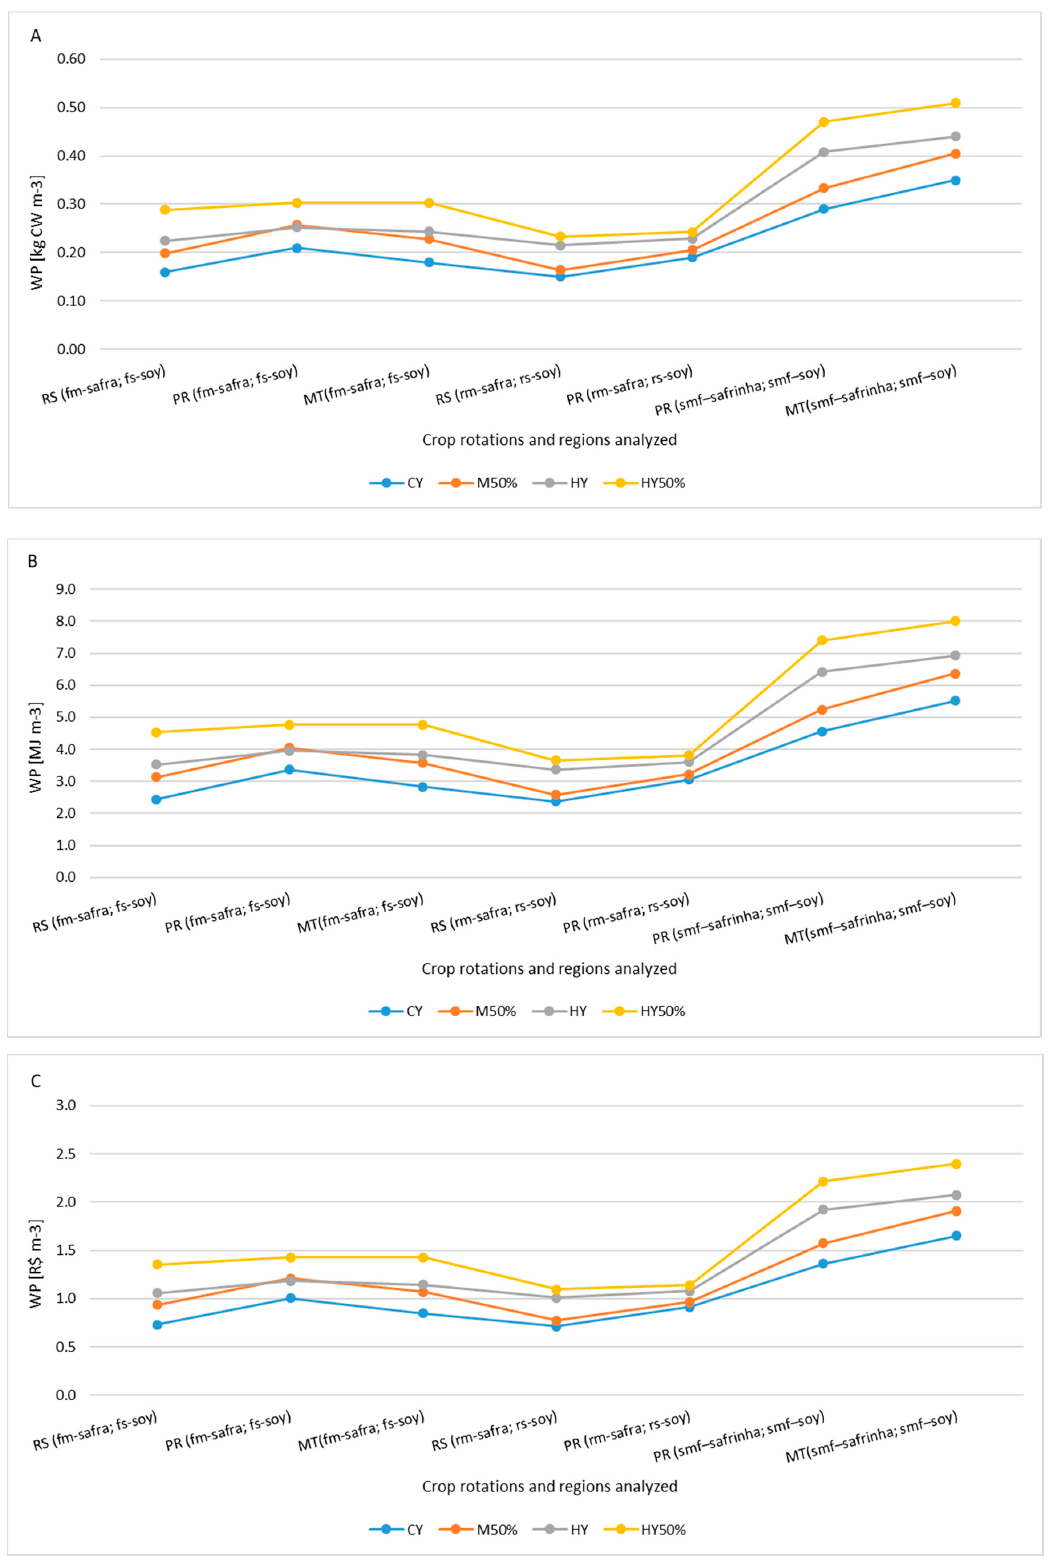
Figure 5. Water productivity of pig pork production considering the crop rotation systems and the 2nd scenario (M50%), 3rd scenario (HY), and 4th scenario (HY50%). ( A ) Carcass Weight reference unit (WP indirect+direct,pig,Mass,Farm ). ( B ) Food Energy reference unit (WP indirect+direct,pig,Energy,Farm ). ( C ) Monetary reference unit (WP indirect+direct,pig,Mon,Farm ). s—soy; m—maize; f—fallow; r—ryegrass. WP indirect+direct,broiler,Mass,Farm could be improved by 15.4% (2nd scenario (M50%)), 25.4% (3rd scenario (HY)), or 44.7% (4th scenario (HY50%)) considering the implementation of best crop management scenarios for safrinha (smf– safrinha ) and soy (smf–soy) produced in MT. Considering the same crop rotation and source, WP indirect+direct,pig,Mass,Farm could be improved by 15.6% (2nd scenario (M50%)), 25.7% (3nd scenario (HY)), or 45.4% (4th scenario (HY50%))). WP indirect+direct,Mass,Farm varied according to the crop rotation system applied for animal feed production. The highest values of WP indirect+direct,broiler,Mass,Farm (0.53 kgCW m − 3 ) and WP indirect+direct,pig,Mass,Farm (0.35 kgCW m − 3 ) were found in MT for crop rotation composed of safrinha (smf– safrinha ) and soy (smf- soy), which were 139% and 132% higher, respectively, than the lowest values considering animal feed produced in RS (rm- sa fra; rs-soy). An amount of water-saving (Q indirect,Feed ) of 0.0336 km 3 year − 1 and 0.0202 km 3 year − 1 could be attained if broilers and pigs would be fed with safrinha (smf- safrinha ) and soy (smf–soy) produced in MT rather than safra (rm- safra ) and soy (rs-soy) produced in RS. This potential amount of water-saving represents 0.07%, 0.06%, and 0.09% of the total water demand for rainfed maize and soy produced in the States of Paraná (PR), Mato Grosso (MT), and Rio Grande do Sul (RS), respectively, for broiler feed production and 0.04%, 0.04%, and 0.05% for pig feed production in the same states [17]. The highest water productivity found by Drastig et al. [42] for Brazilian poultry farms was 0.33 kgCW m − 3 . Considering the same water demand conditions for feed production, it was close to WP found in this study considering feed (rm- safra ; rs-soy) produced in RS, 0.30 kgCW m − 3 and in PR, 0.35 kgCW m − 3 . A higher WP of 0.87 kgCW m − 3 was found in this study considering animal feed produced in MT (smf– safrinha ; smf–soy), which was 163.3% higher than the highest WP found by Drastig et al. [42]. It reinforces the importance of crop rotation and the source of feed (producer region) in the WP of animals produced in the studied watershed. In Germany, Krauß et al., [52] found a similar WP of 0.30 kgCW m − 3 while Renault et al., [67] found a lower WP of 0.24 kgCW m − 3 in California, USA. The last lower WP value could be associated with different yield index and crop management techniques applied in the 1990s in the US. The WP of 0.29 kgCW m − 3 found in the USA in the period of 2014/16 [66] was almost the same as found in this study for animal feed produced in PR (rm-safra; rs-soy) of 0.28 kgCW m − 3 and 45.3% lower than the highest WP of 0.53 kgCW m − 3 found for broiler feed produced in MT (smf– safrinha ; smf–soy). In California, USA, Renault et al. [67] found a pig WP of 0.21 kg CW − 1 m − 3 while Mekonnen et al. [66] found 0.25 kg CW − 1 m − 3 for the USA, which was close to the mean value (0.22 kgCW m − 3 ) found in this study considering all crop rotations and grain production regions analyzed.